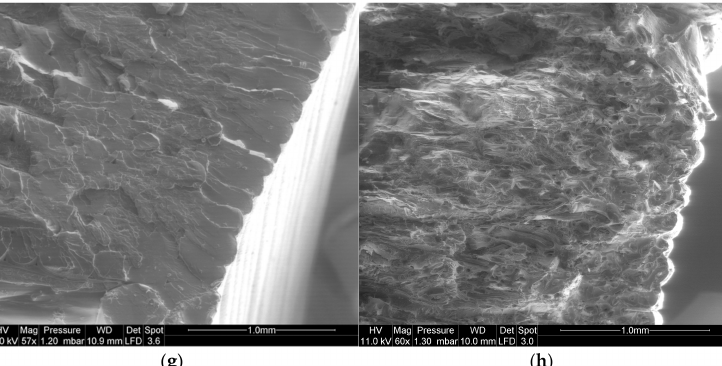
Figure 9. SEM micrograph showing the effect of printing angle on the topography of PLA and PLA-flax fractured surfaces (T P = 200 ◦ C, T B = 60 ◦ C): ( a ) PLA Θ = 0 ◦ ; ( b ) PLA-flax Θ = 0 ◦ ; ( c ) PLA Θ = 15 ◦ ; ( d ) PLA-flax Θ = 15 ◦ ; ( e ) PLA Θ = 30 ◦ ; ( f ) PLA-flax Θ = 30 ◦ ; ( g ) PLA Θ = 45 ◦ ; ( h ) PLA-flax Θ = 45 ◦ .